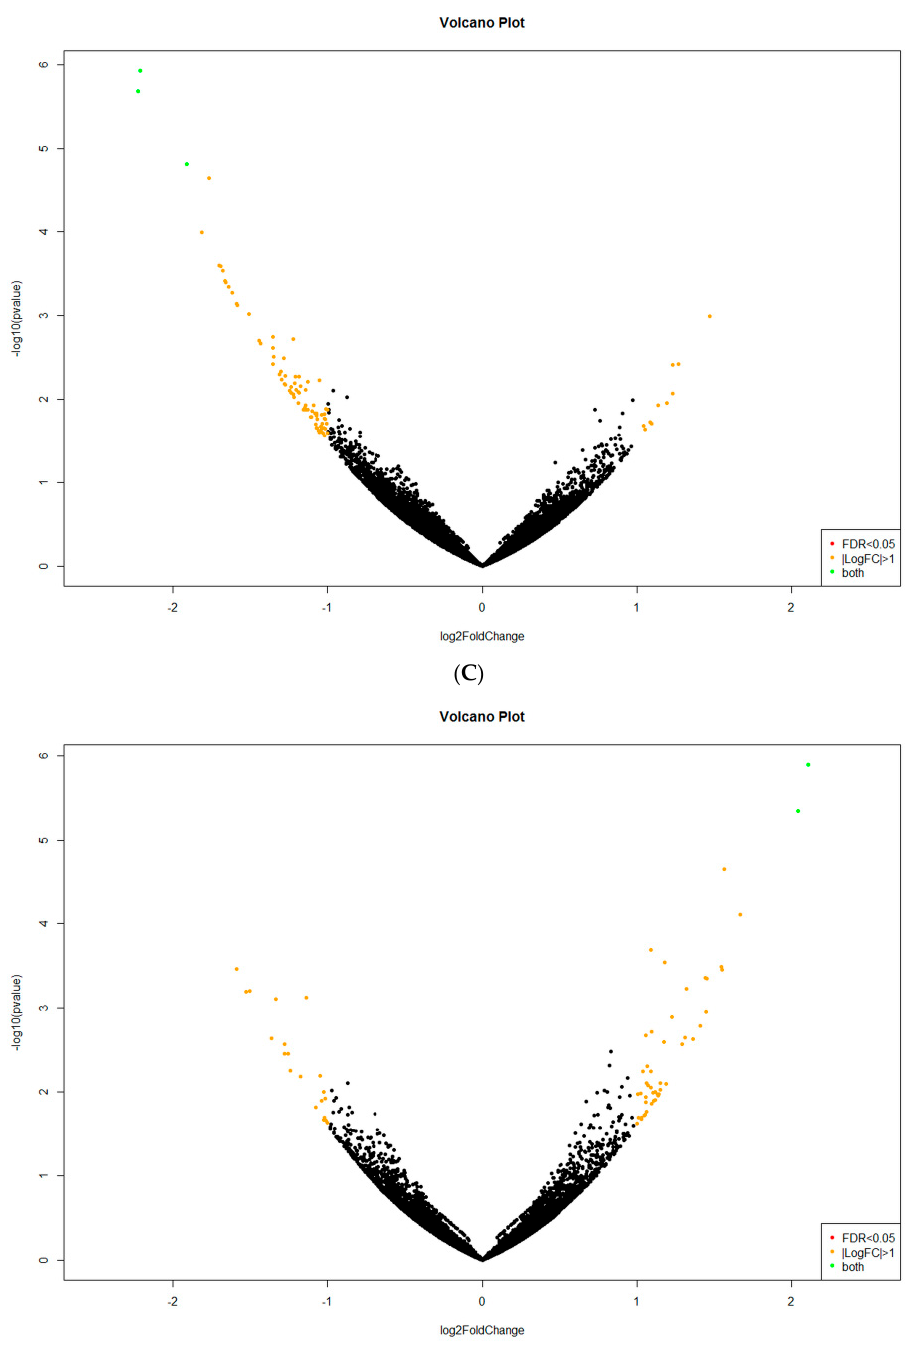
Figure A1. Volcano plots demonstrating C. unicolor genes displaying a significantly changed expression profile (large fold change values) and high statistical significance (as evidenced by the p -values) during fungus growth in different lighting conditions and darkness: ( A ) white vs. dark; ( B ) blue vs. dark; ( C ) green vs. dark; and ( D ) red vs. dark. The data for all detected transcripts are plotted as log2 fold change (X-axis) versus the − log10 of the adjusted p -value (Y-axis). Significantly up-regulated or down-regulated genes (at least four-fold at p < 0.05) are highlighted as green dots.